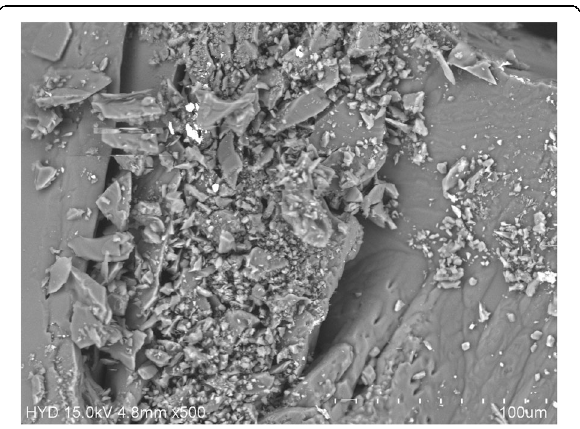
Fig. 13 SEM image of 0.058 g/ml methanol obtained from cooling